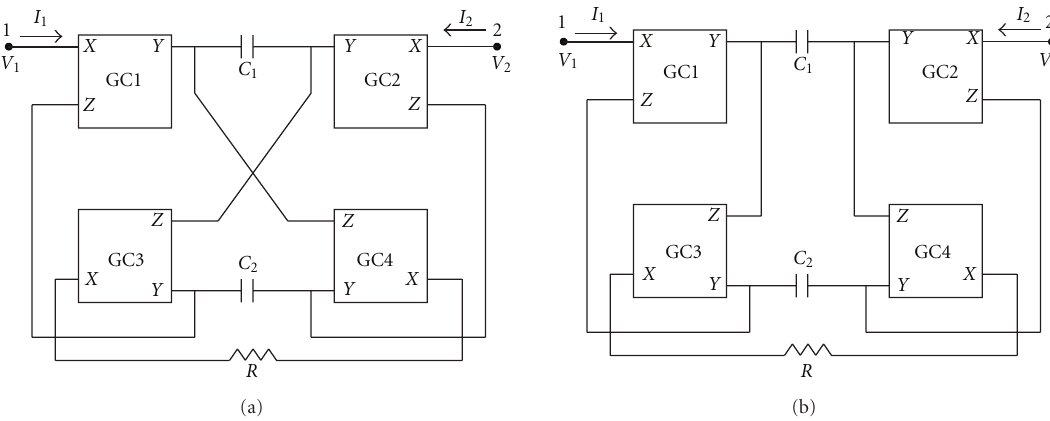
Figure 5: (a) New floating circuit 1 suitable for FDNR realization. (b) New floating circuit 2 suitable for FDNR realization.